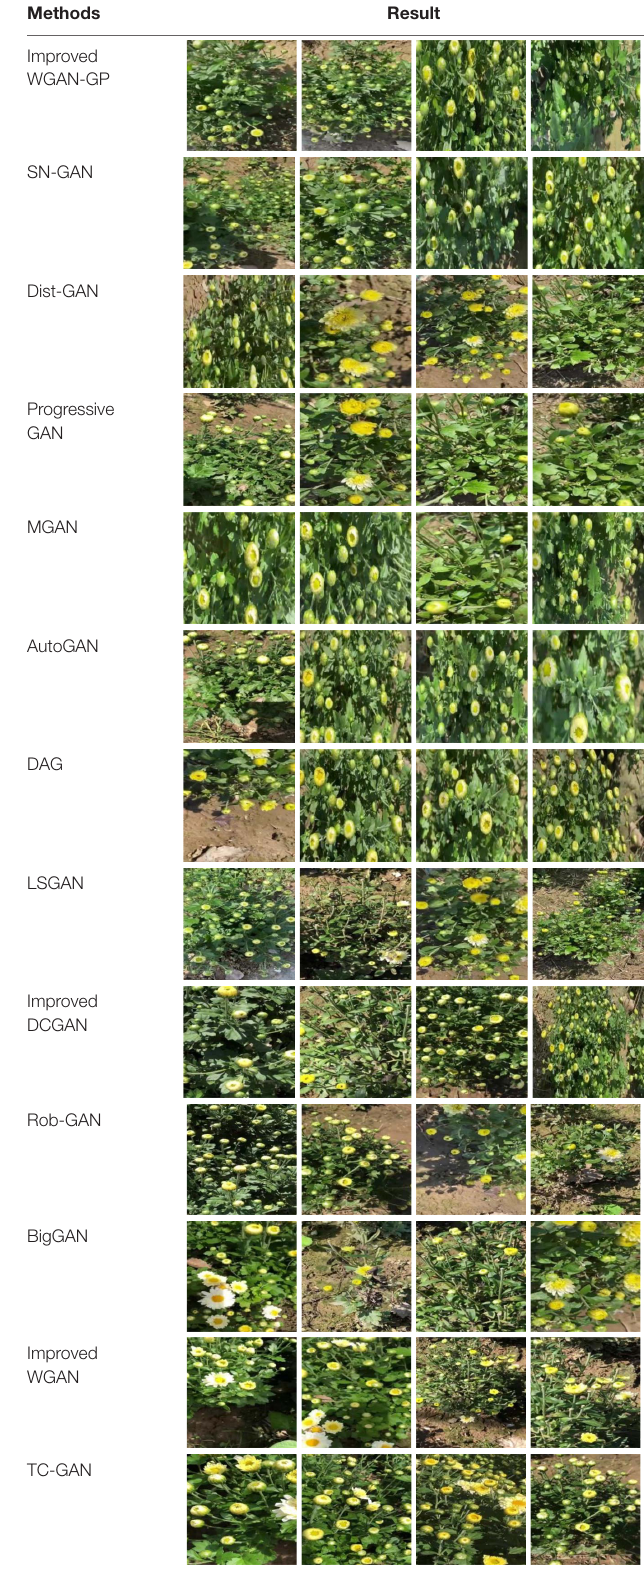
TABLE 6 | Comparison between tea chrysanthemum – generative adversarial network (TC-GAN) and state-of-the-art GANs.